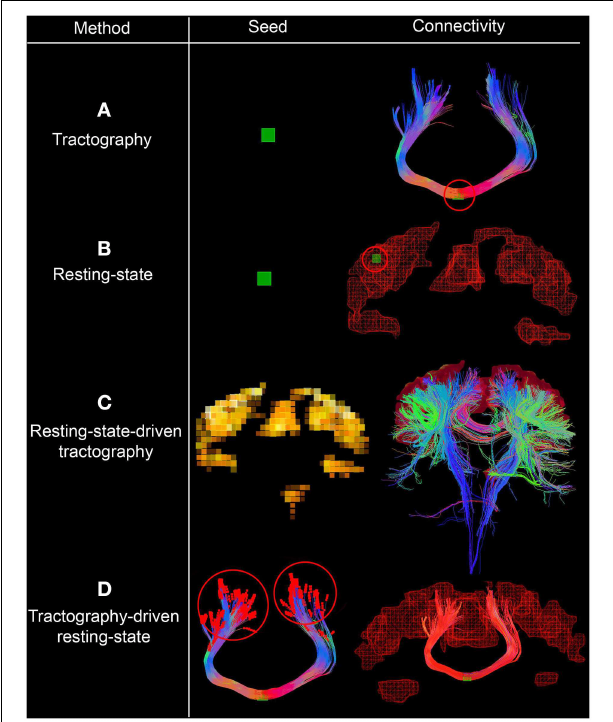
FIGURE 1 | Interactive seeding methods proposed for structural and functional connectivity. In (A,B) , one can see the traditional approaches for generating structural and functional connectivity using a seed-ROI (green box, circled red on the right). (C) Shows the use of functional connectivity for the generation of underlying structural connections by initiating tractography from each rs-fMRI cluster. (D) Shows a streamline-specific map revealing the underlying functional connectivity associated to the bundle of interest (i.e., corpus callosum, red). Note how functional connectivity extends far beyond the white matter seed points red circles. Supplementary video available online at: www.youtube.com/watch?v=eHSyf2AjbHw.